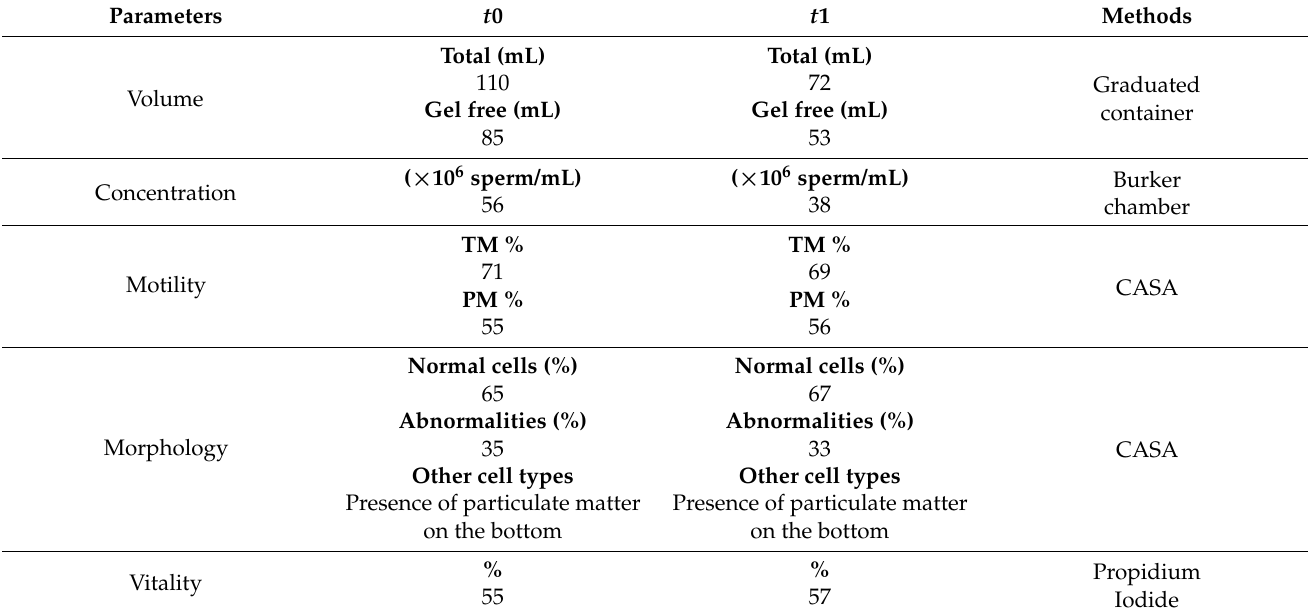
Table 3. Comparison of spermiograms performed at t 0 (prior to tumor onset) and at t 1 (three months after surgery). Volume was measured using a graduated container; concentration was assessed using a Burker Chamber; Total Motility (TM) and Progressive motility (PM) were evaluated using a CASA System, set to 30 frames per fields and 60 Hz per rate (CASA IVOS, Hamilton Torne). Vitality was assessed using a fluorescent stain with propidium